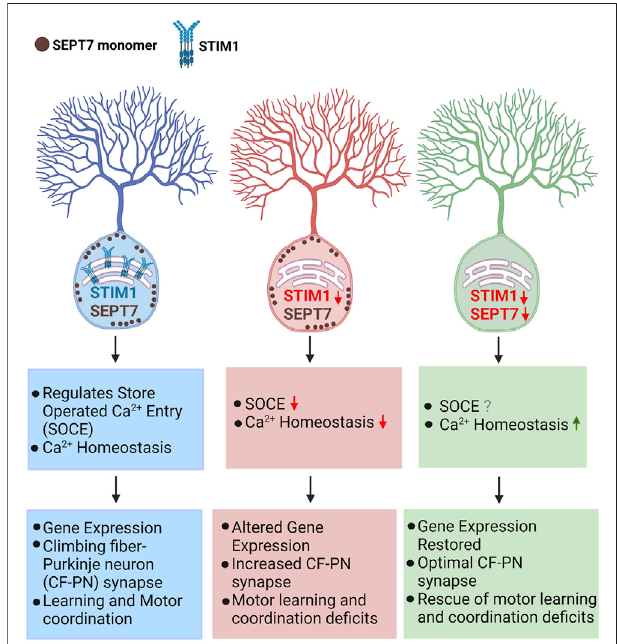
FIGURE 6 | Cellular and behavioral effects of reducing SEPT7 in mice with loss of STIM1 in Purkinje neurons loss of STIM1 in Purkinje neurons attenuate Ca 2+ entry and affect ER-Ca 2+ re fi lling which in turn suppresses mGluR1-stimulated Ca 2+ signals and Purkinje neuron excitability (Hartmann et al., 2014; Ryu et al., 2017; Dhanya and Hasan, 2021). These changes affect gene expression and optimal synaptic connectivity of cerebellar Purkinje neurons with age (Dhanya and Hasan, 2021). Reducing or abolishing SEPT7 in STIM1 KO PNs restored gene expression which is accompanied by normal CF-PN innervation and an improved ability to learn a motor coordination task in aging mice. [Model created using Biorender